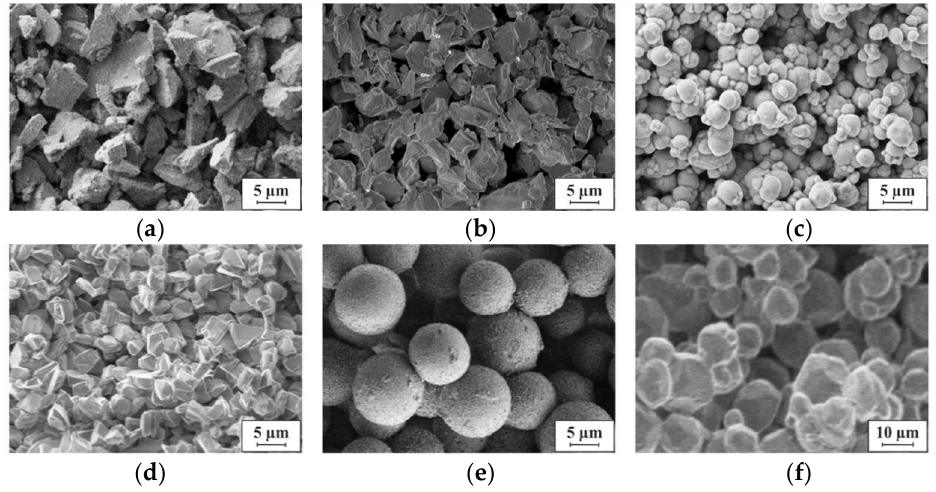
Figure 10. SEM micrographs of porous 3D microstructures solidified by 75 nm ALD-Al 2 O 3 and made of powders from different materials, with varying mean particle size d: ( a ) d = 9 µm Al 2 O 3 , ( b ) d = 5 µm NdFeB, ( c ) d = 1 µm carbonyl iron, ( d ) d = 5 µm diamond, ( e ) d = 10 µm oxidized silicon beads, ( f ) d = 14 µm phosphor. Between the particles empty voids form a network of pores.